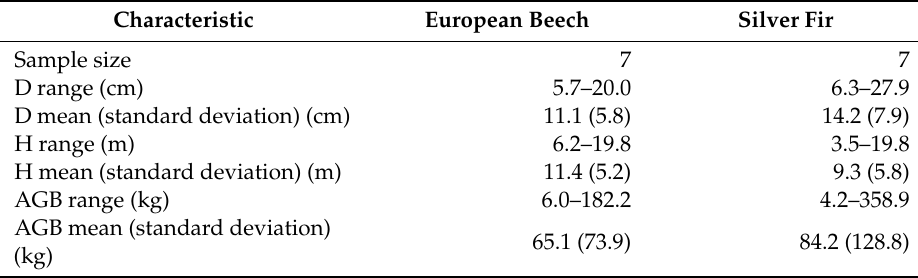
Table 2. The characteristics of reduced site-specific sample (Dataset